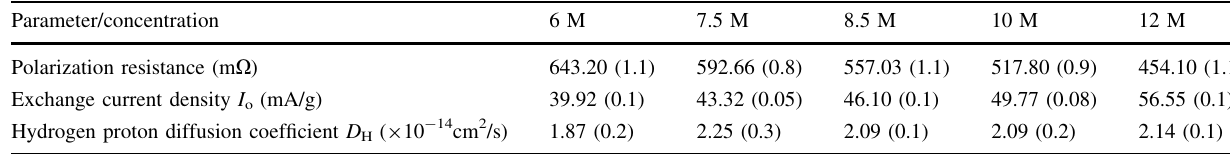
Table 2 Exchange current density and diffusion coefficient as a function of the electrolyte concentration Parameter/concentration 6